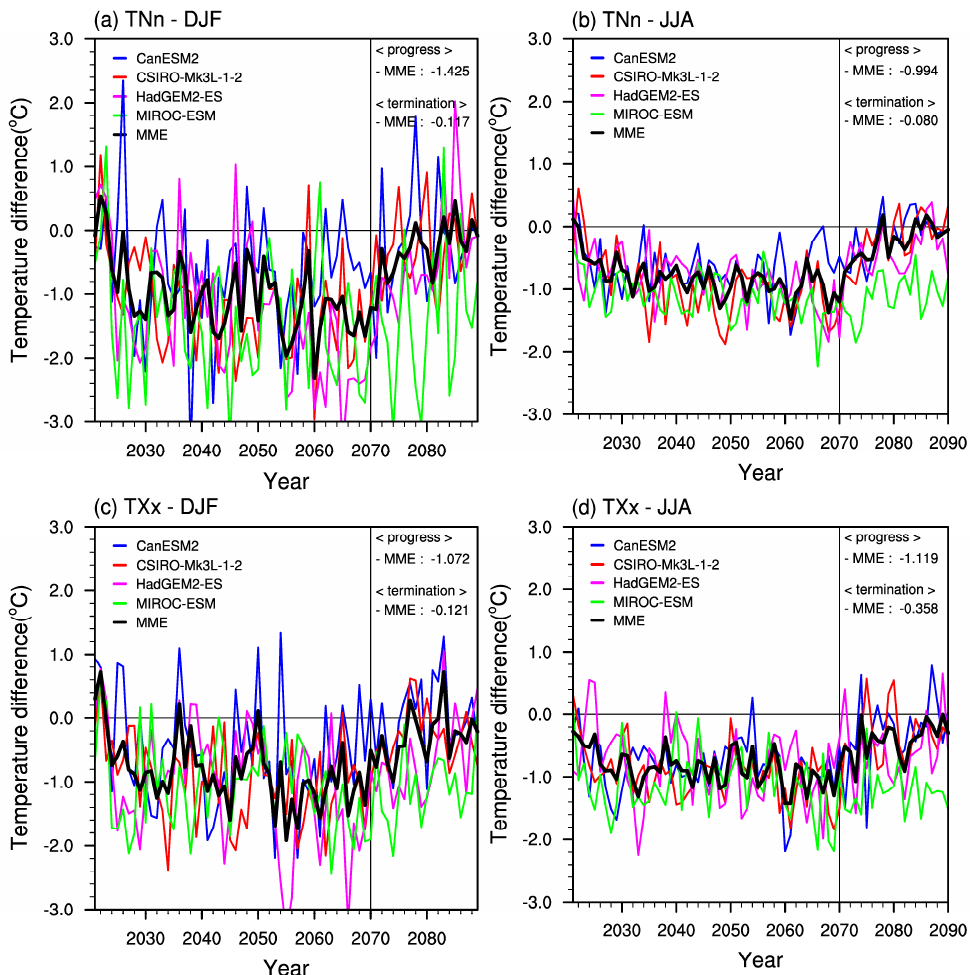
Figure 6. Time series of the difference in the extreme temperature indices ( a,b ) TNn and ( c,d ) TXx between the G4cdnc and RCP4.5 simulations over East Asia for ( a,c ) December‐January‐February (DJF) and ( b,d ) June‐July‐August (JJA). The heavy dark curve is the multi‐model ensemble mean used in this study, excluding the MIROC‐ESM model. The multi‐model ensemble means for the last 10 years of the progress and termination periods are located in right upper corner of each plot.